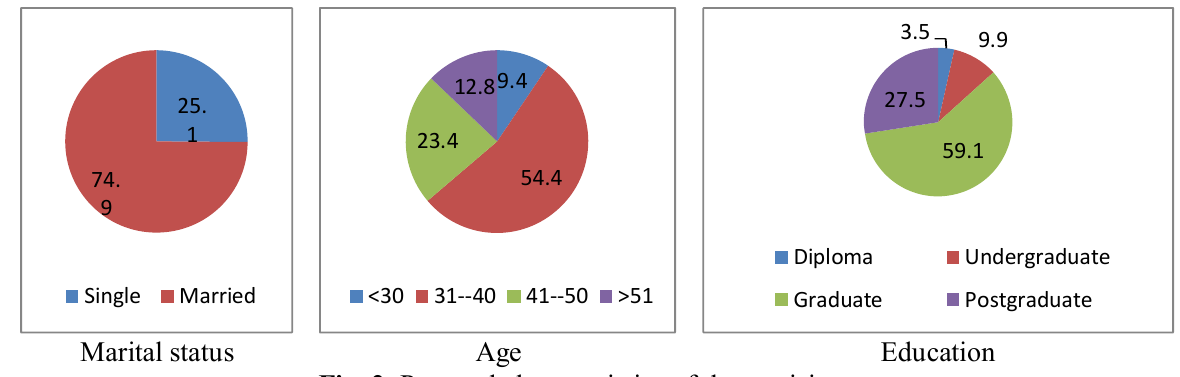
Fig. 2. Personal characteristics of the participants